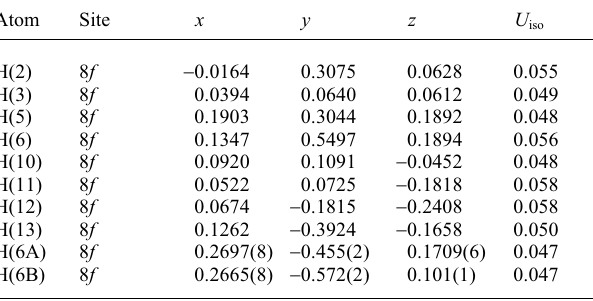
Table 2. Atomic coordinates and displacement parameters (in Å 2 )